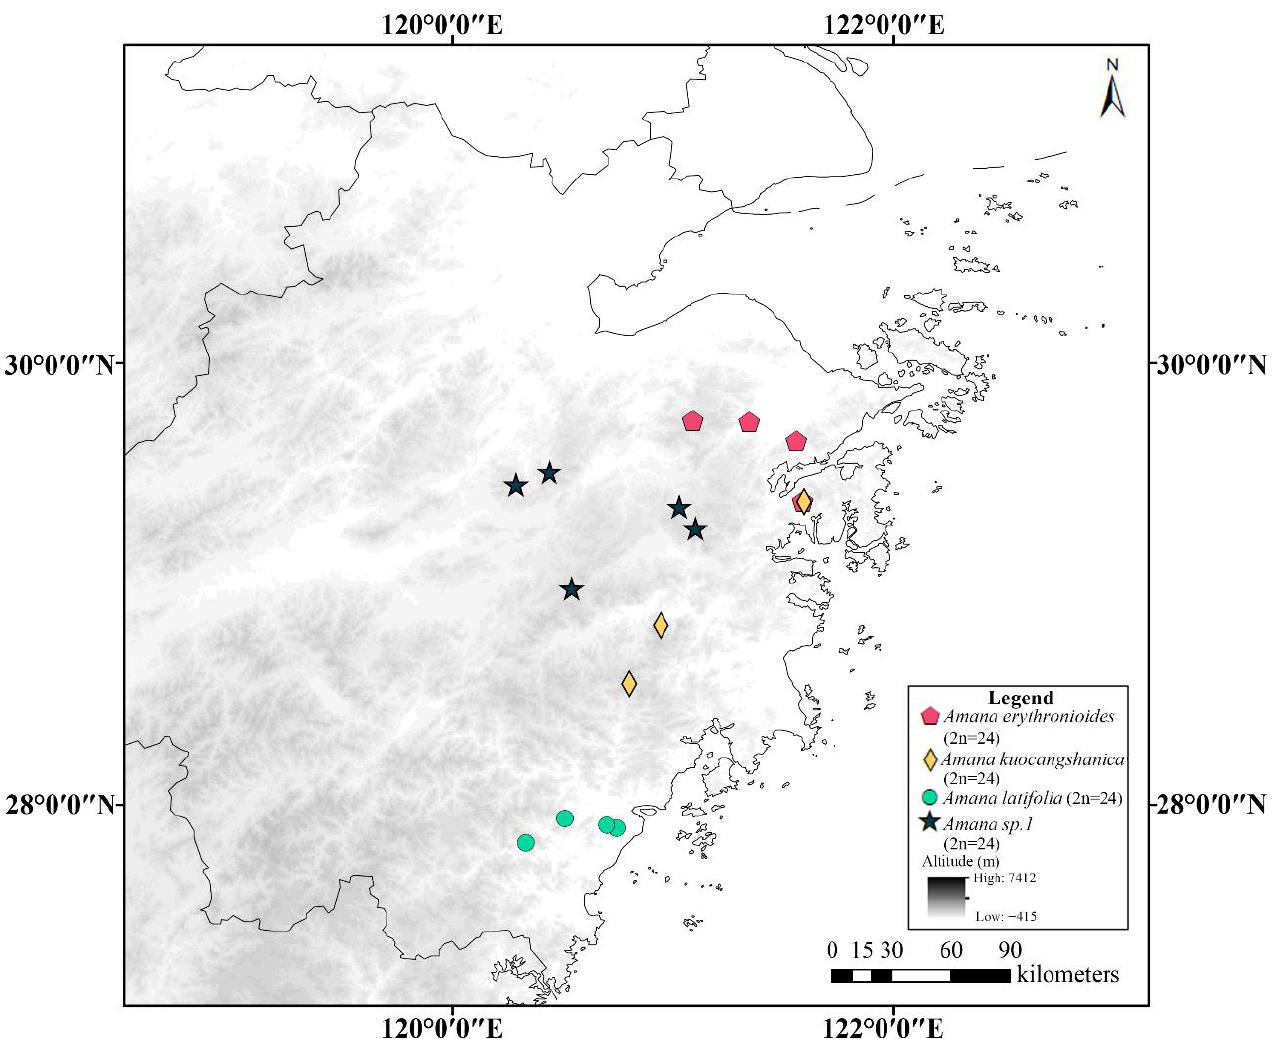
Figure 4. Distribution of ploidy levels of Amana erythronioides , A. kuocangshanica , A. latifolia and Amana sp.1 in Zhejiang Province. All four species are diploid (2 n = 2 x = 24). The species of Clade III ( A. wanzhensis , A. baohuaensis , A. anhuiensis and Amana sp.2 ) show a much wider and parapatric distribution (Figure 5). We detected six populations of A. wanzhensis (at elevations of 300–1130 m, central Zhejiang to southeastern Anhui), six of A. baohuaensis (at elevations of 70–350 m, southwestern Jiangsu to eastern Anhui), three of A. anhuiensis (at elevations of 700–1200 m, southwestern Anhui and northwestern Jiangxi) and three of Amana sp.2 (at elevations of 160–530 m, along Mt. Dabie bordering Henan and Hubei). All the populations that we examined are